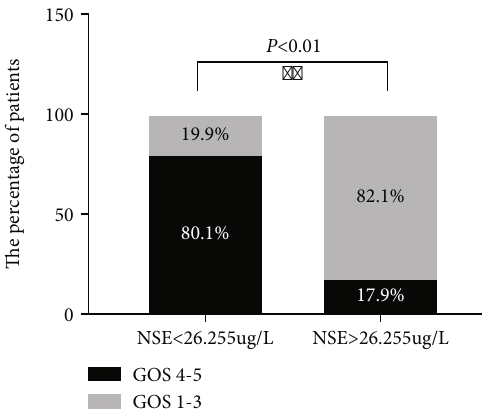
Figure 6: Distribution of di ff erent prognosis of aSAH patients with the highest NSE value greater than 26.255 μ g/L and NSE less than 26.255 μ